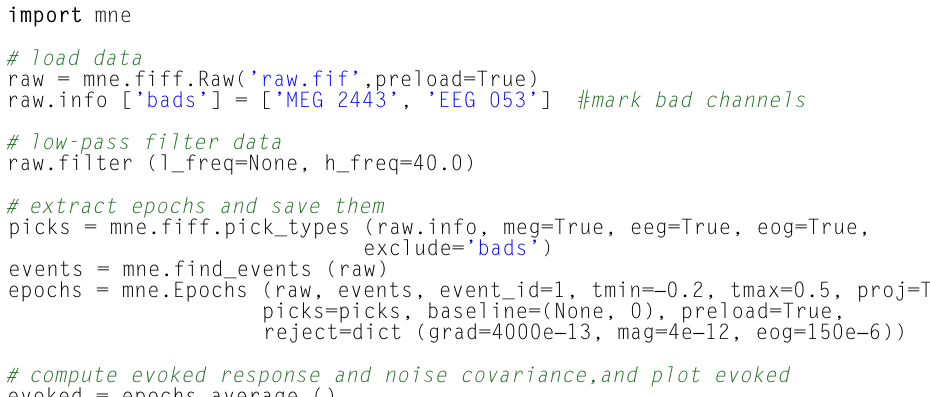
Table 1 | From raw data to dSPM source estimates in less than 30 lines of code. import